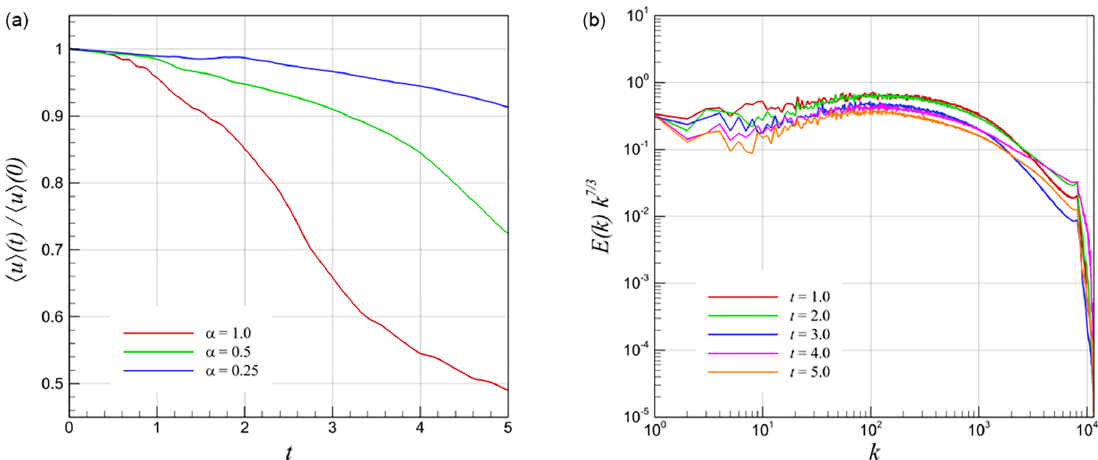
Figure 9. Time evolution of 3-D KHI turbulence field characteristics with a resolution of N 3 = 512 3 , showing normalized root mean square values of velocity u for various α values (a) , and compensated energy spectra computed from u at various times for α = 1 . 0 (b)